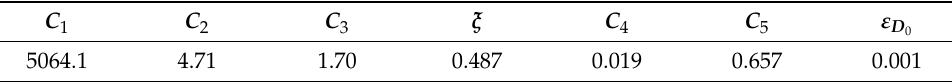
Table 1. Material parameters for HCP [54,70].